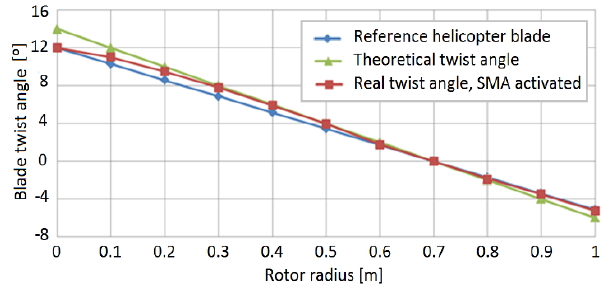
Fig. 4. Geometric blade twist